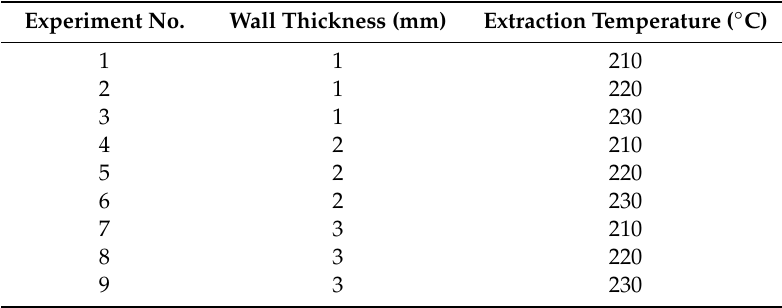
Table 2. L 9 orthogonal array with the process parameters and their levels.